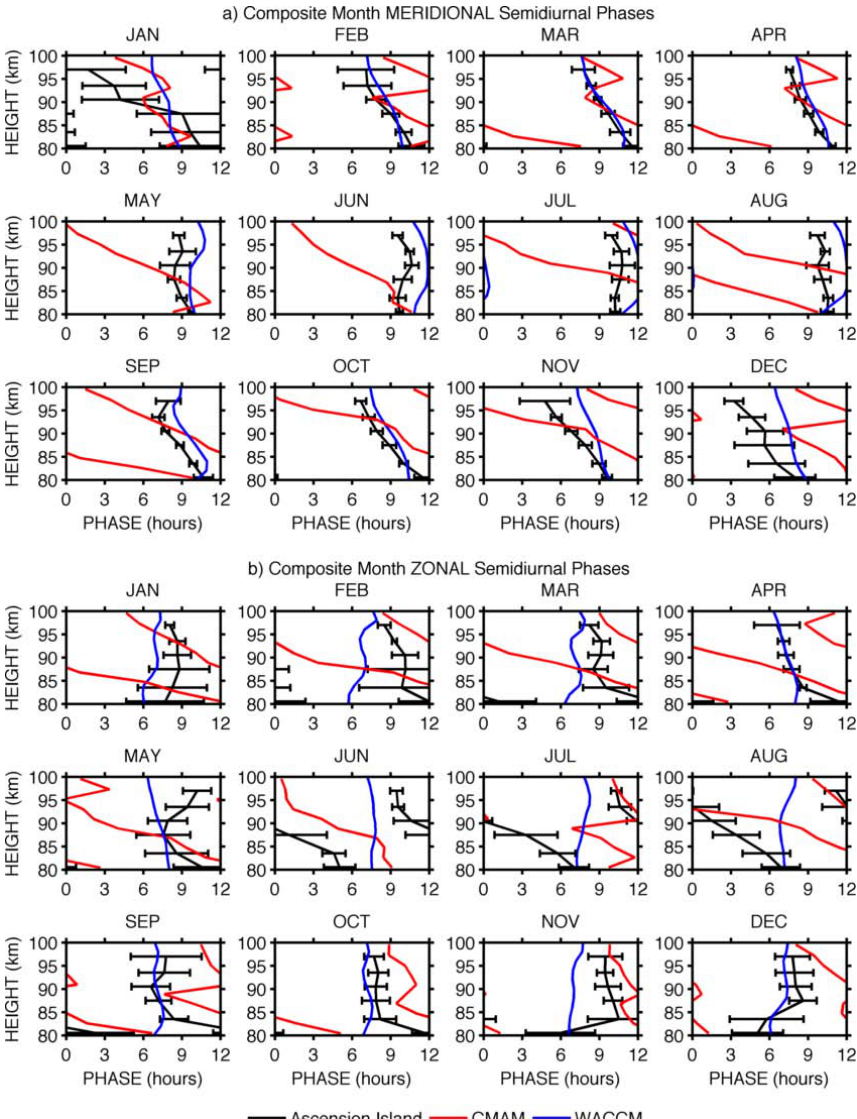
Fig. 11. Phases of the (a) meridional and (b) zonal semidiurnal tide as a function of month and height. The error bars on the radar observations (black lines) indicate the standard deviation of the individual monthly means over the interval 2002–2011. Also plotted are the predictions of eCMAM (red lines) and WACCM (blue